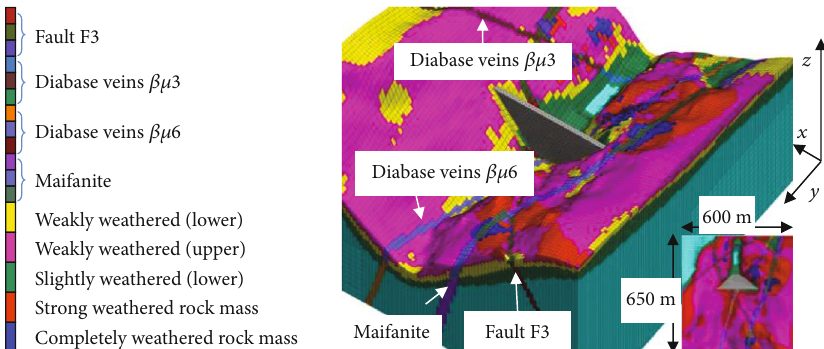
Figure 8: Seepage-stress coupling analysis model of slope in the lower reservoir area of the Zhouning hydropower station.